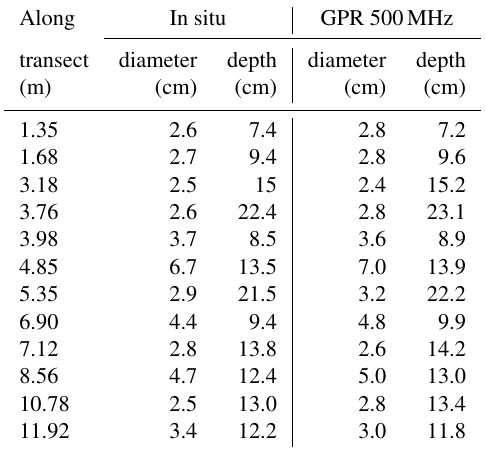
Table 3. Calibration and validation of roots (diameter and depth). This table represents the information extracted from a radargram of a pine–oak stand (Fig. S4).